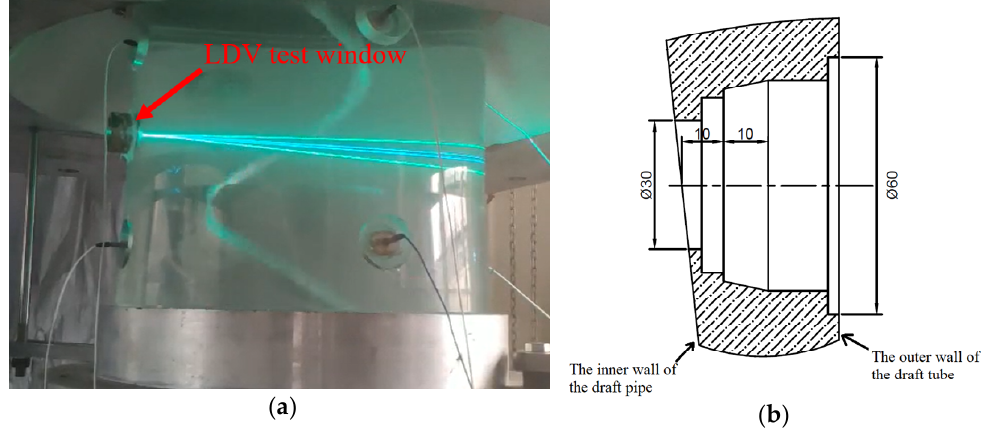
Figure 12. Test system. ( a ) Test location and ( b ) test window drawings. The monitoring points are arranged on the radial line between the center point of the test window and the center of the test section. The test radius is R. Twenty-nine test points are arranged. The distance between measuring points near the wall is 0.01 R, with a total value of 10 (including the wall points). Moreover, the distance between the remaining